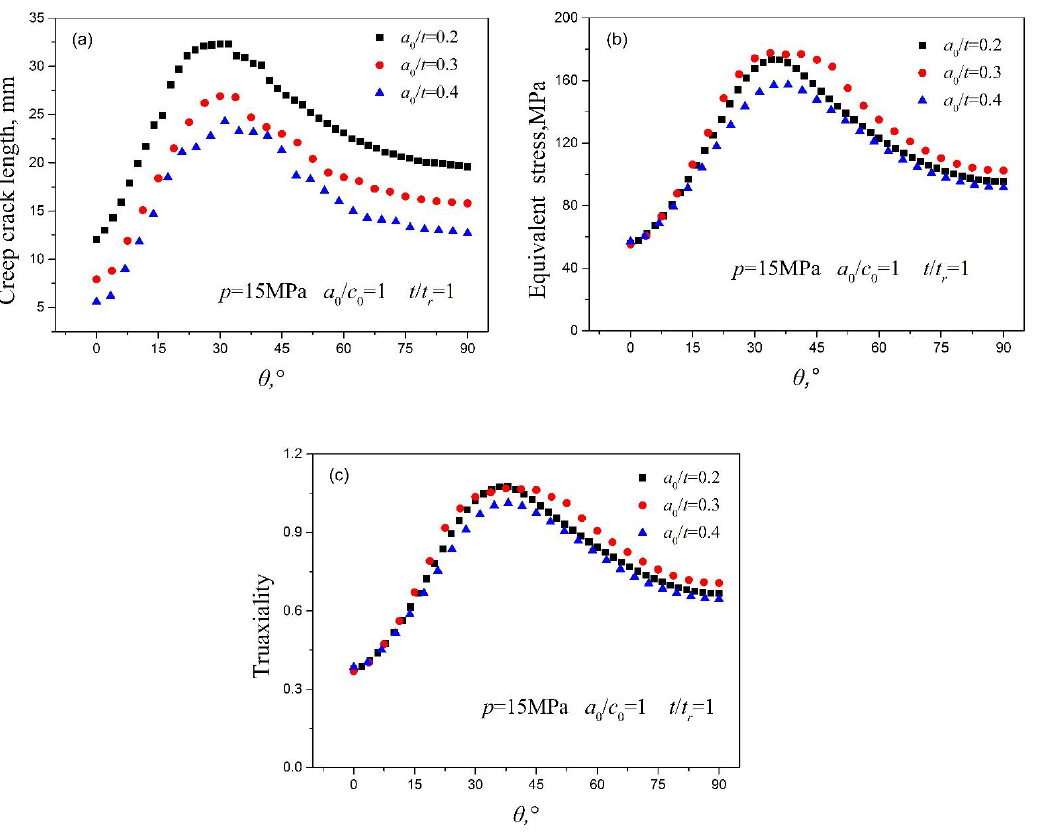
Figure 16. The relationship between the ( a ) creep crack length, ( b ) equivalent stress, ( c ) triaxiality and θ .